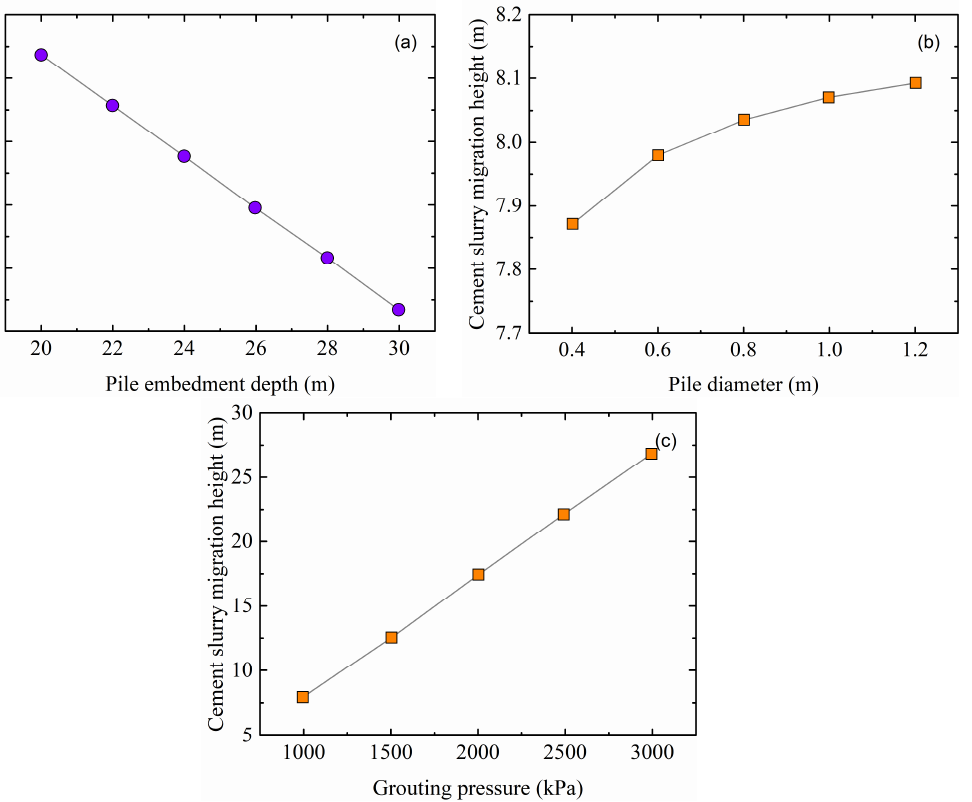
Figure 3. Correlations of cement slurry migration height with: ( a ) pile embedment depth; ( b ) pile diameter; and ( c ) grouting pressure.